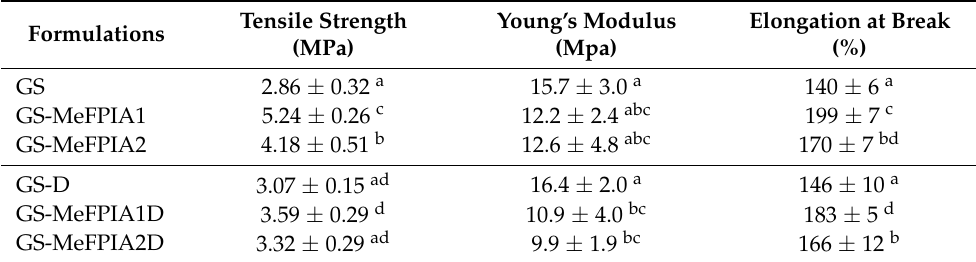
Table 2. Mechanical parameters of gelatin-based